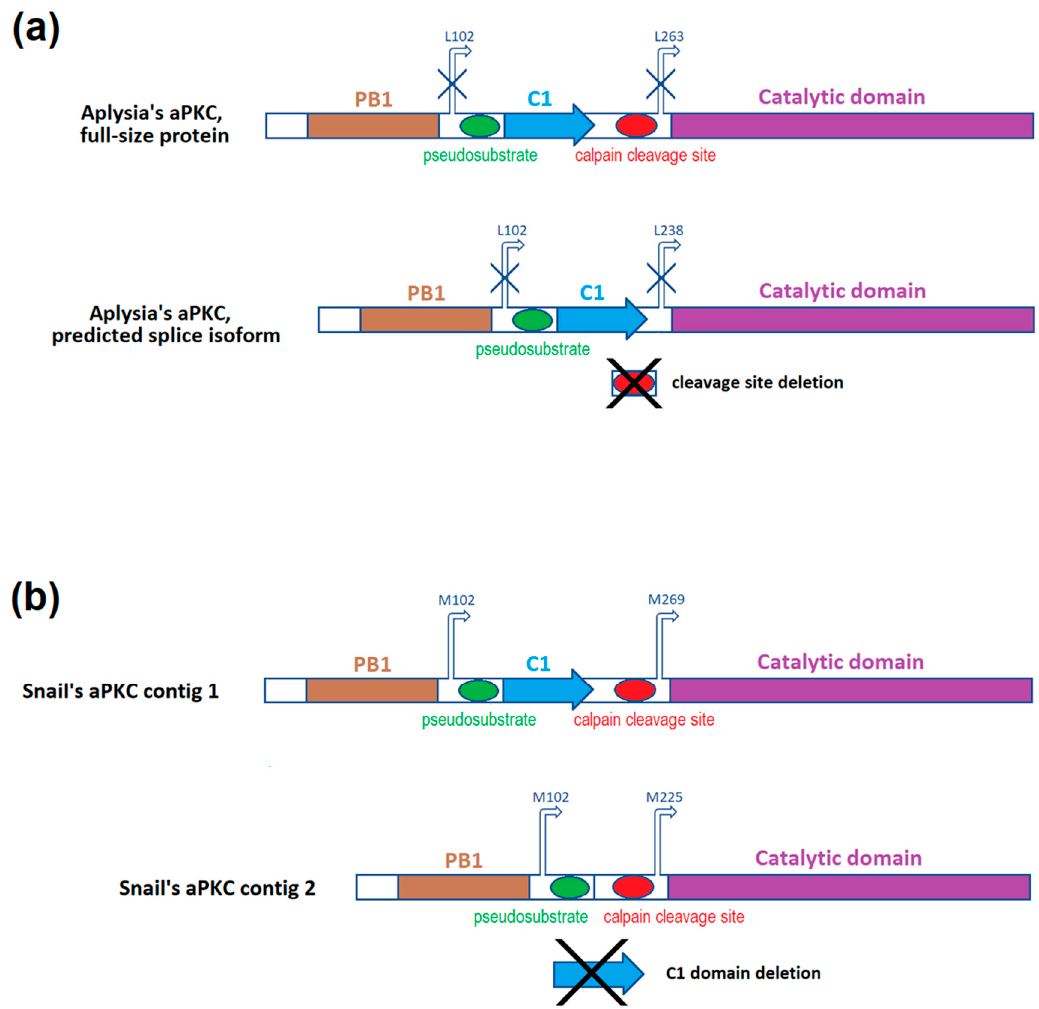
Figure 2. ( a ) Domains and features of two isoforms of Aplysia’s aPKC kinase (based on the paper by Bougie et al., 2009 [36]); ( b ) Domains and features of two Helix lucorum aPKC contigs (assembled from snail full-transcriptome sequencing data) based on similarity with Aplysia’s sequences. Arrows above the molecule represent possible translation starts (present only in snail sequences; corresponding sites in Aplysia’s sequences are marked with crossed arrows).